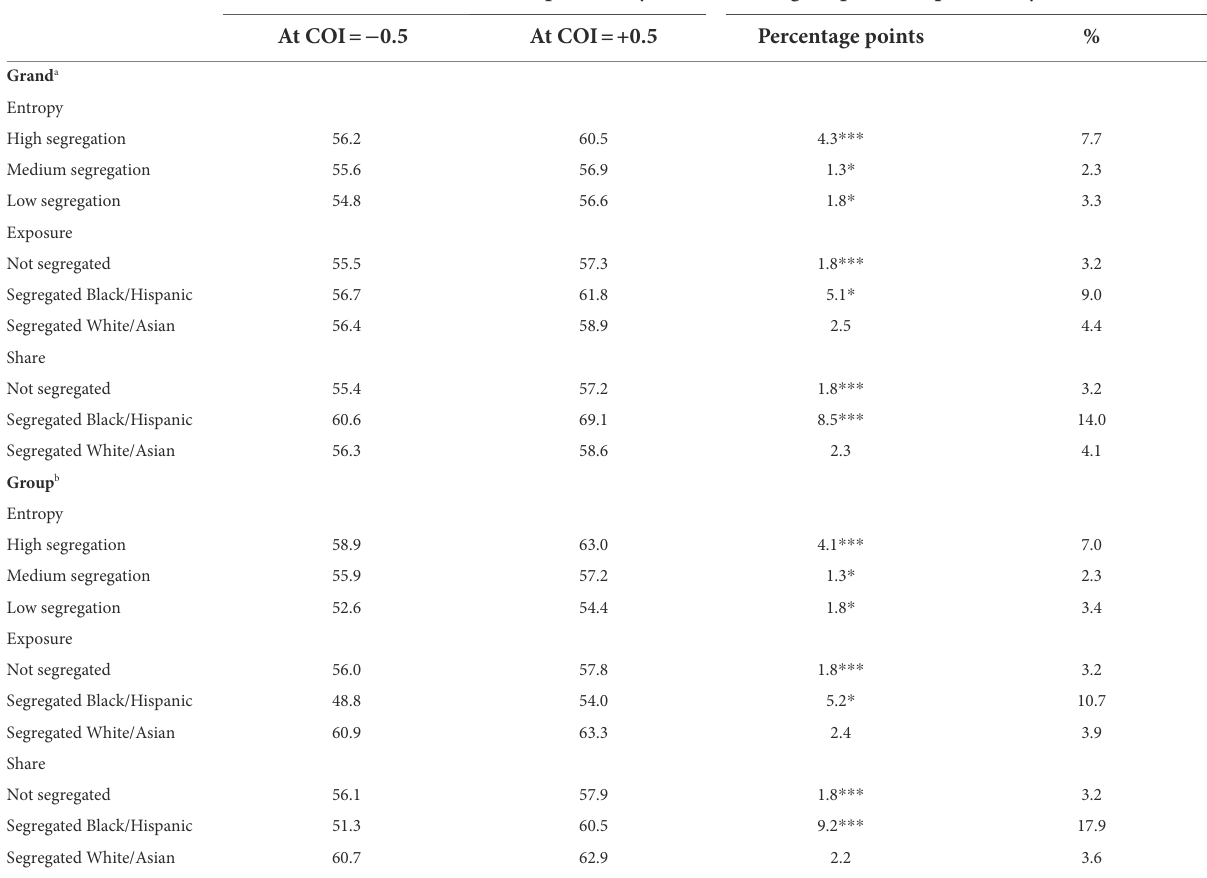
TABLE 6 Change in predicted school readiness likelihood by interaction